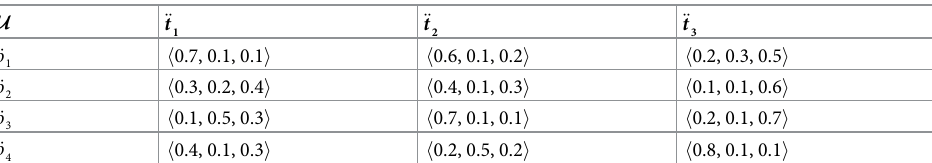
Table 1. Vertices set of PFHSG.